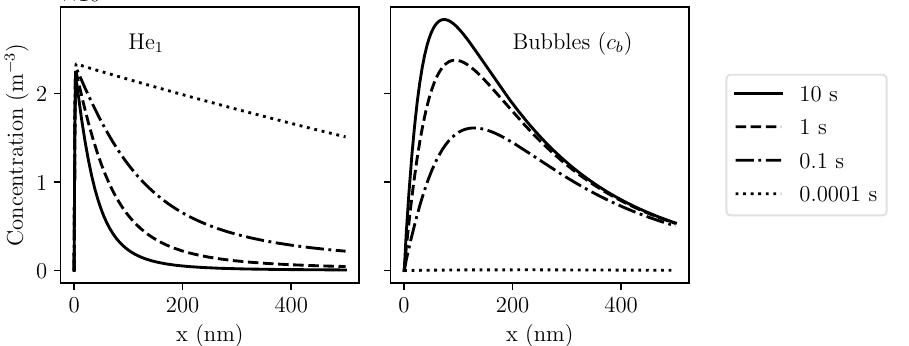
Figure 3. Concentration profiles of He 1 (left) and bubbles (right) in W exposed to 100 eV He at 10 22 m − 2 s − 1 and 1000